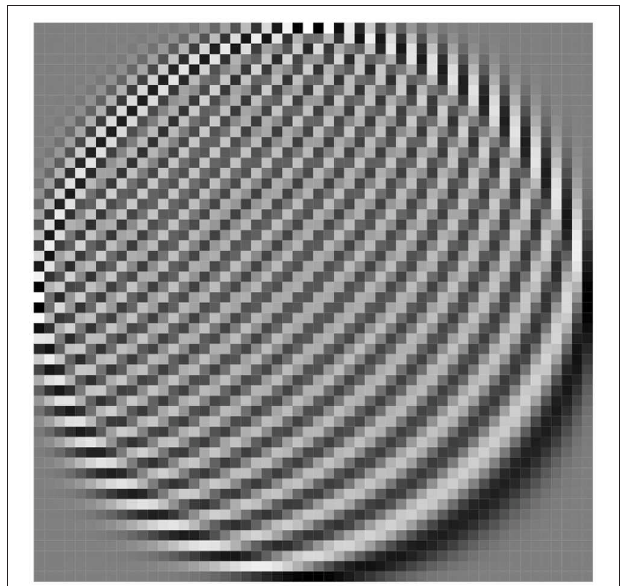
53 / 2. The values of a real =